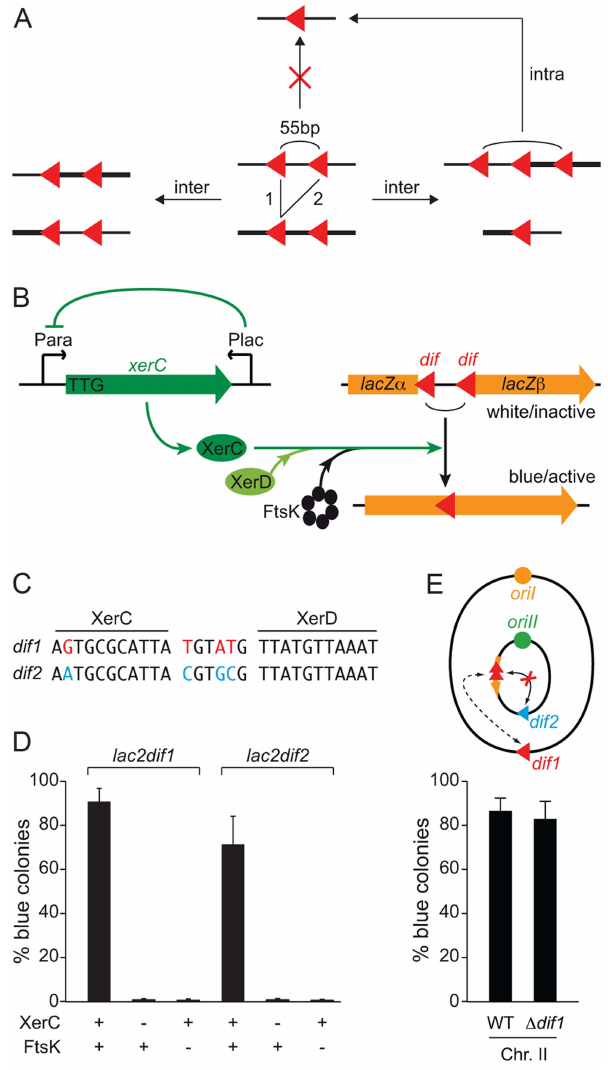
Figure 2. FtsK-dependent Xer recombination at dif as a tool to monitor sister chromatid contacts. A. Scheme of the different site- specific recombination products that can be obtained when intramolec- ular recombination is impeded. B. Schematic representation of the 55 bp dif -recombination cassettes and the Xer recombination control set up. The orange arrow represents the lacZ gene disrupted by the two dif sites (red triangle). Expression of the xerC gene (green arrow) is under the positive control of the arabinose promoter, P BAD , and the negative control of the E. coli lacZ promoter, P Lac . C. dif1 and dif2 sequence divergence. The DNA binding arms of XerC and XerD are shown. Bases that differ in dif1 and dif2 are shown in red and blue, respectively. D. Reconstitution of a functional lacZ gene depends on XerC and FtsK. Results from at least three independent experiments. E. Recombination between dif sites harboured on different chromosomes does not perturb the SCC detection. Schematic representation of the genome of a strain harbouring lac2dif1 on chrII. No intrachromosomal recombination can occur between lac2dif1 and dif2 because of sequence divergence. The influence of chrI dif1 on chrII lac2dif1 recombination was tested by comparing results obtained in a strain in which dif1 was deleted. Results from at least three independent experiments. Legends as in Figure 1A. Red triangle: dif1 ; blue triangle: dif2